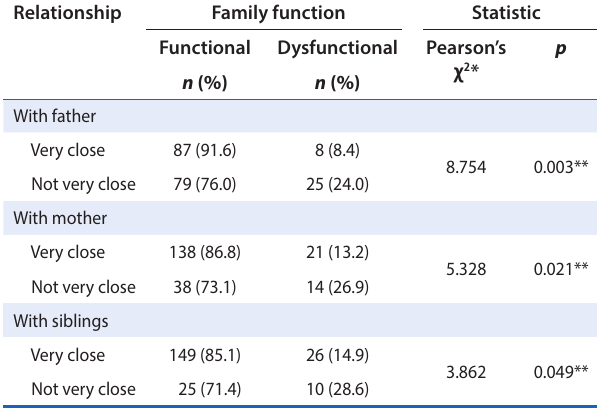
*df = 1. **Significant, n = number.